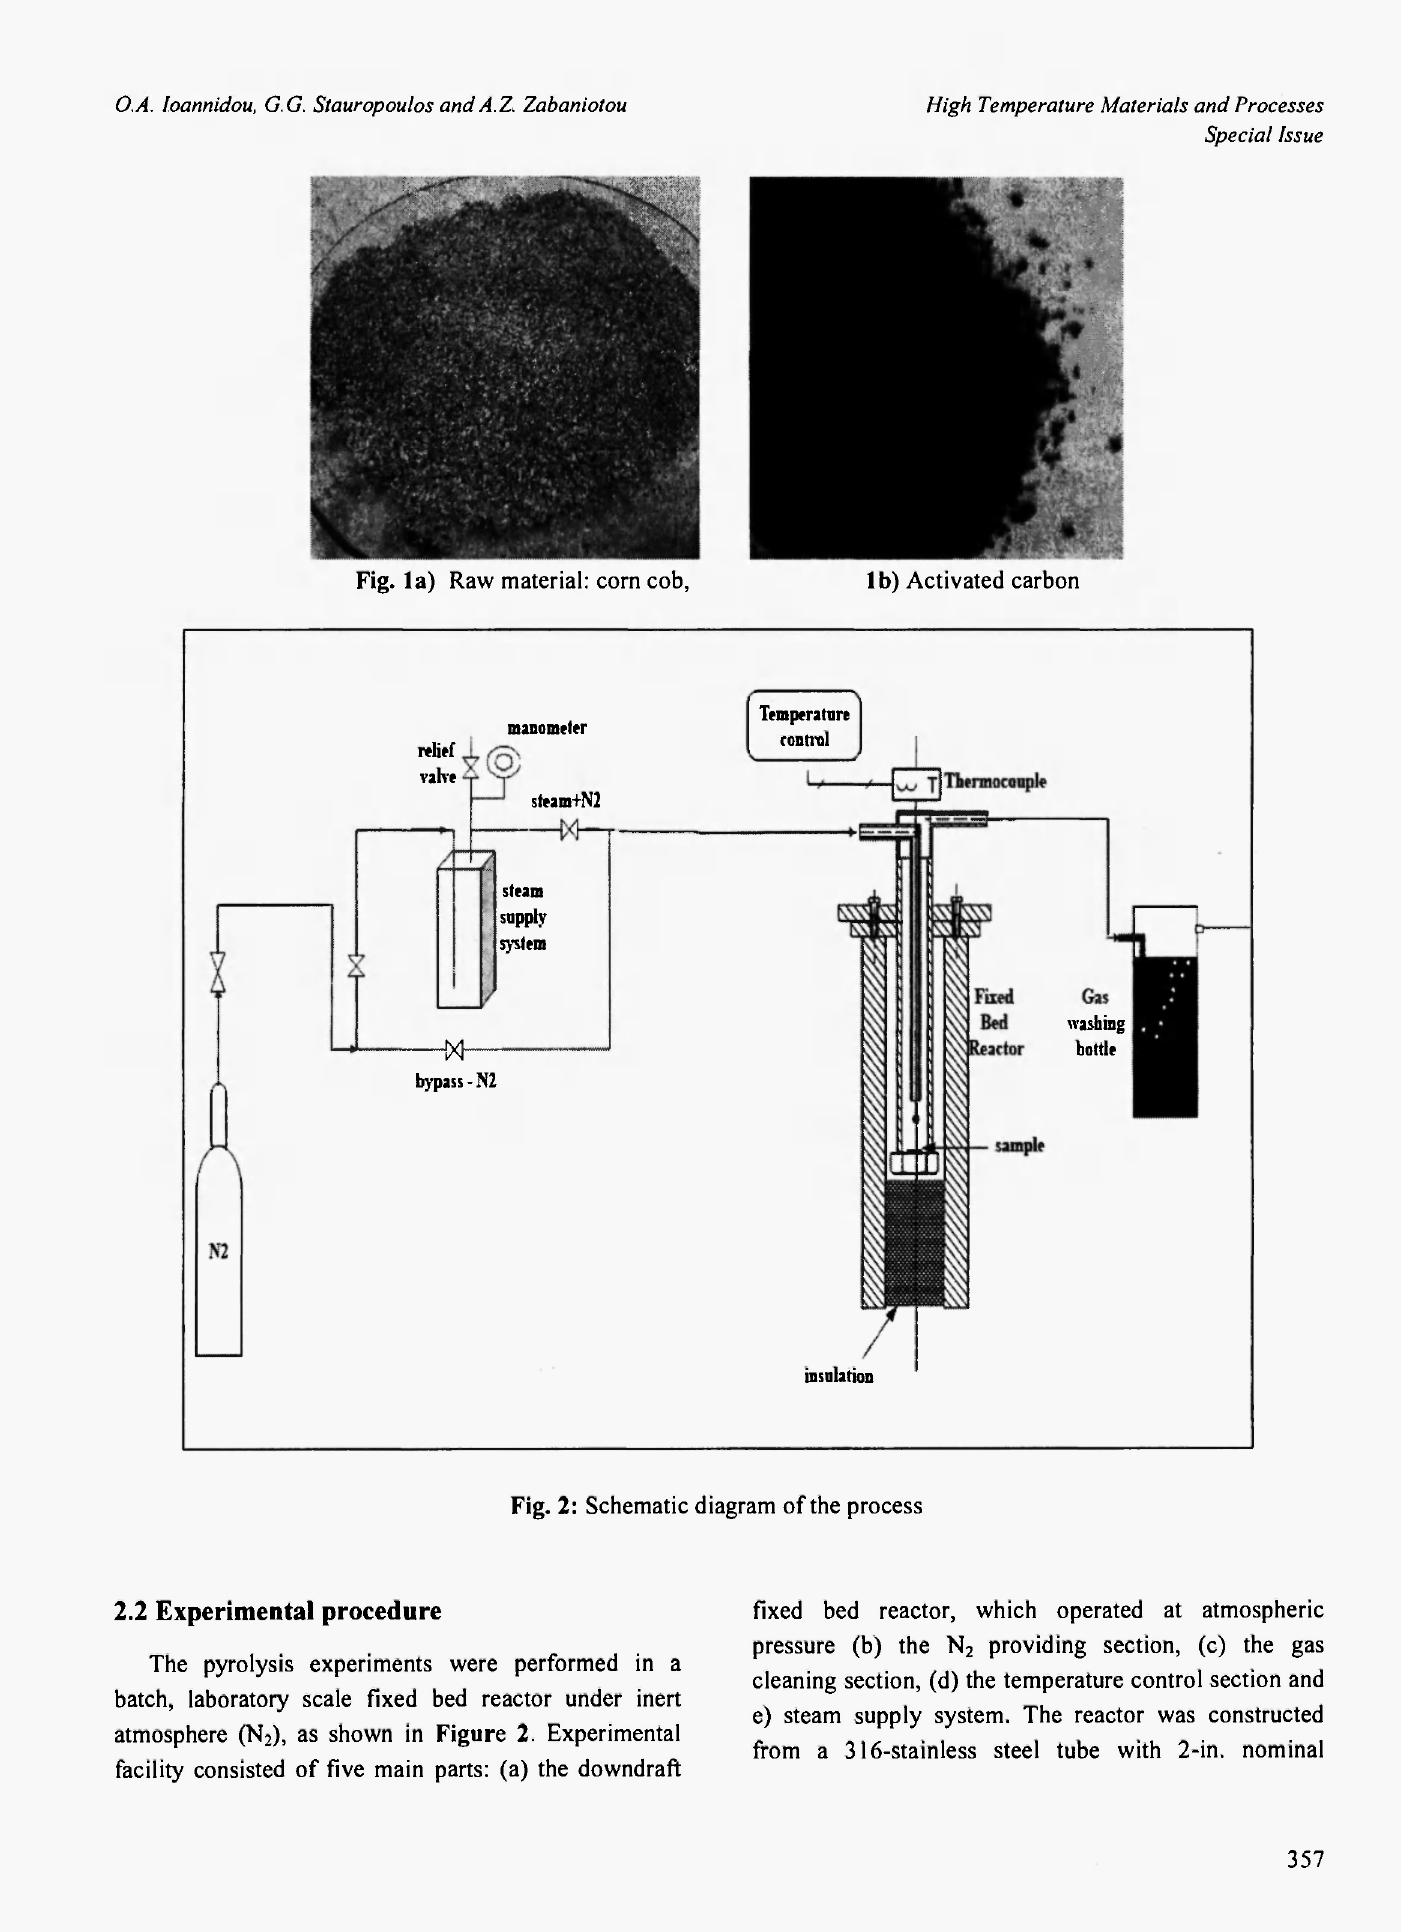
Fig. 2: Schematic diagram of the